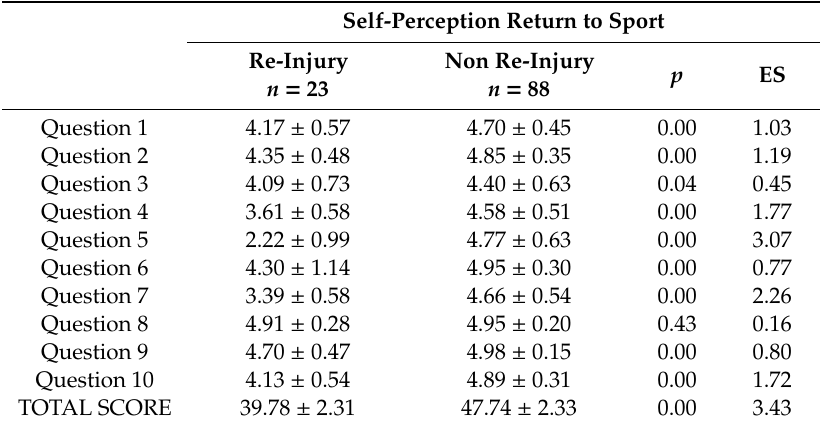
Table 4. Contrasts between scores of the re-injury group and the non re-injury group.